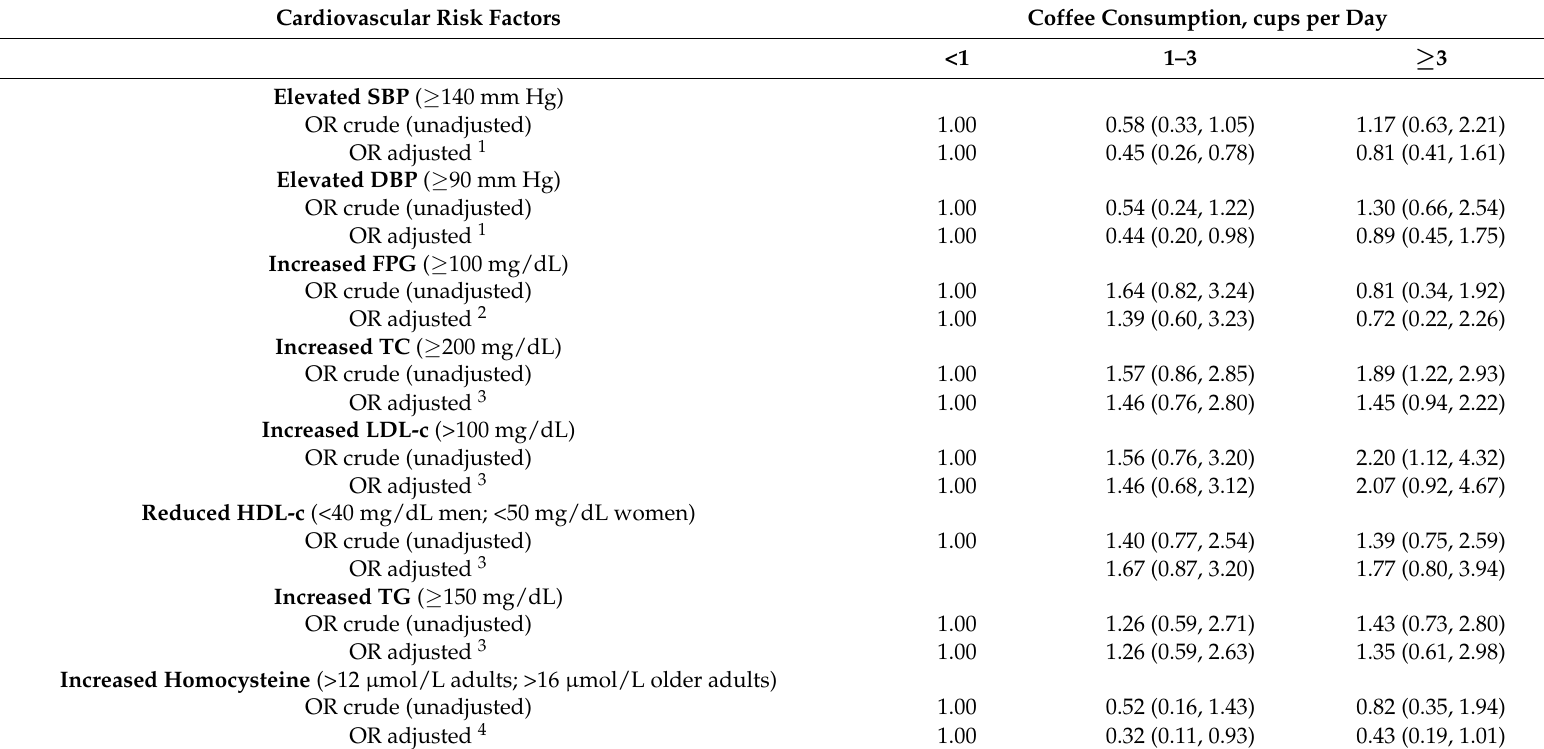
Table 2. Association between cardiovascular risk factors and categories of coffee consumption in Health Survey of S ã o Paulo (ISA-Capital) population. S ã o Paulo, Brazil,